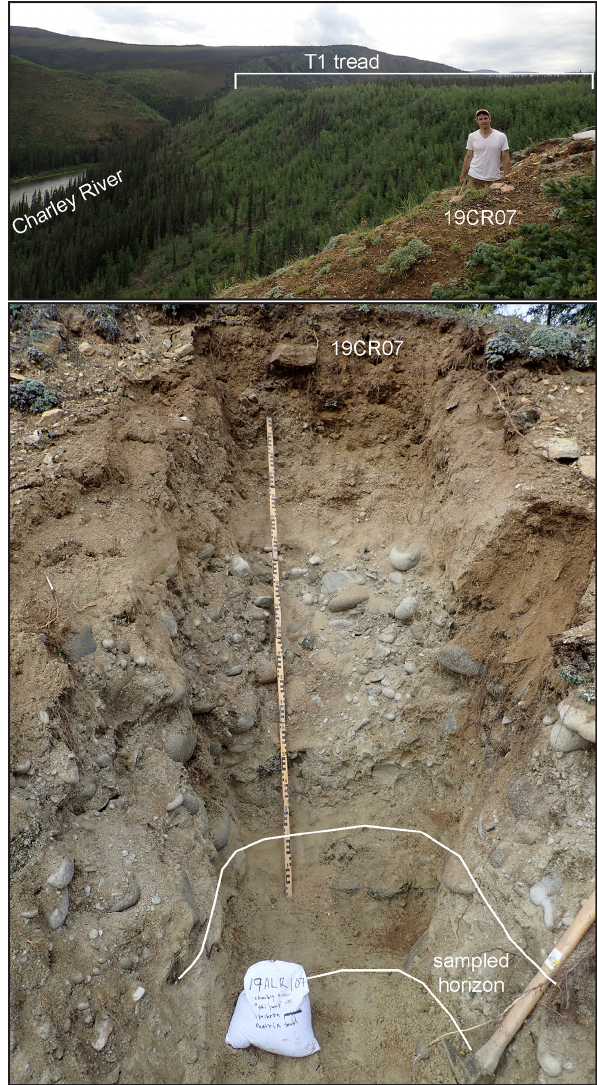
Figure A2. Cosmogenic isochron burial age sample site 19CR07. Site located on the Charley River high terrace (T1) in Alaska ∼ 85km upstream of the Charley–Yukon River confluence. Top photo is taken looking upstream (south–southeast), person is standing in sample pit. Photographs by the US Geological Survey.